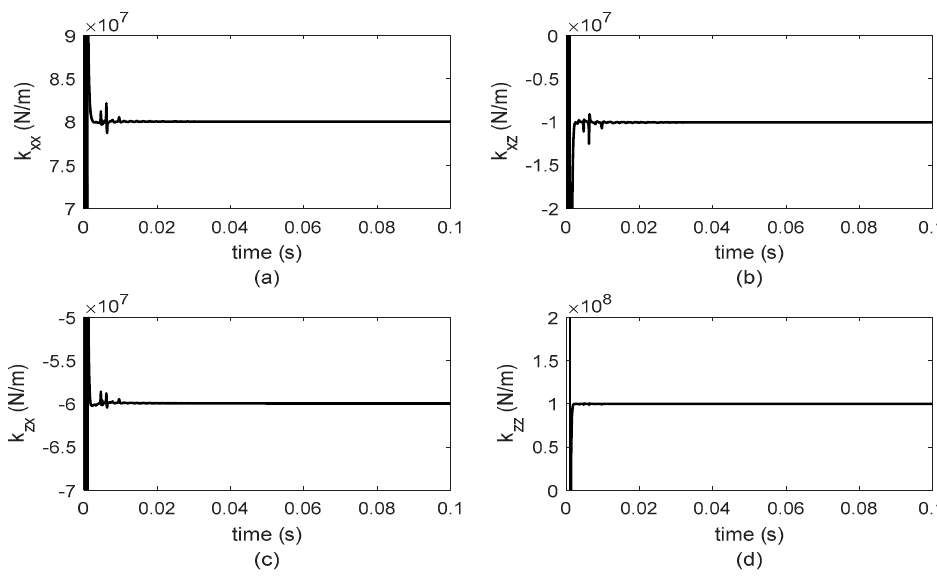
Figure 14. Identified stiffness parameters for bearing 1. ( a ) k xx , ( b ) k xz , ( c ) k zx , ( d ) k zz at 50,000 rpm.